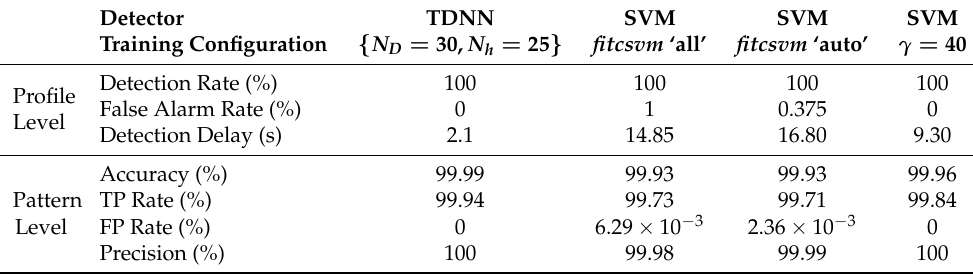
Table 1. Performance of tuned detectors on winter morning peak